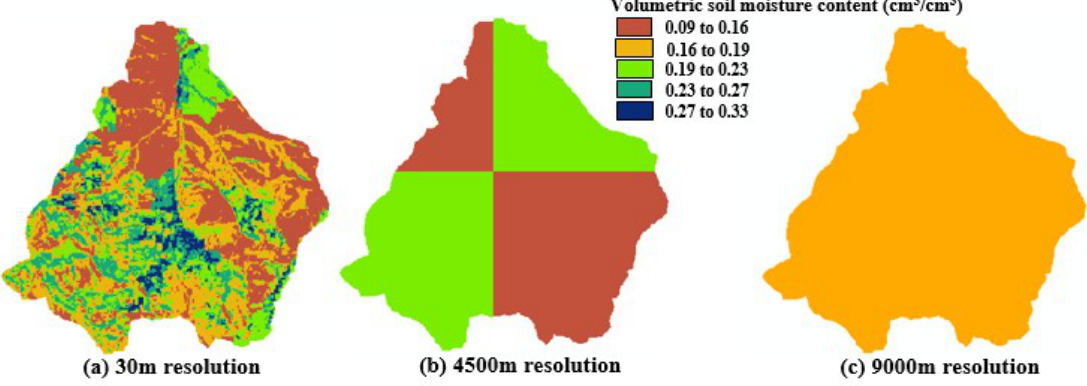
Figure 9. Resampling the 30 m initial soil moisture map( a ) into 4.5 km( b ) and 9 km( c ) grid resolutions.